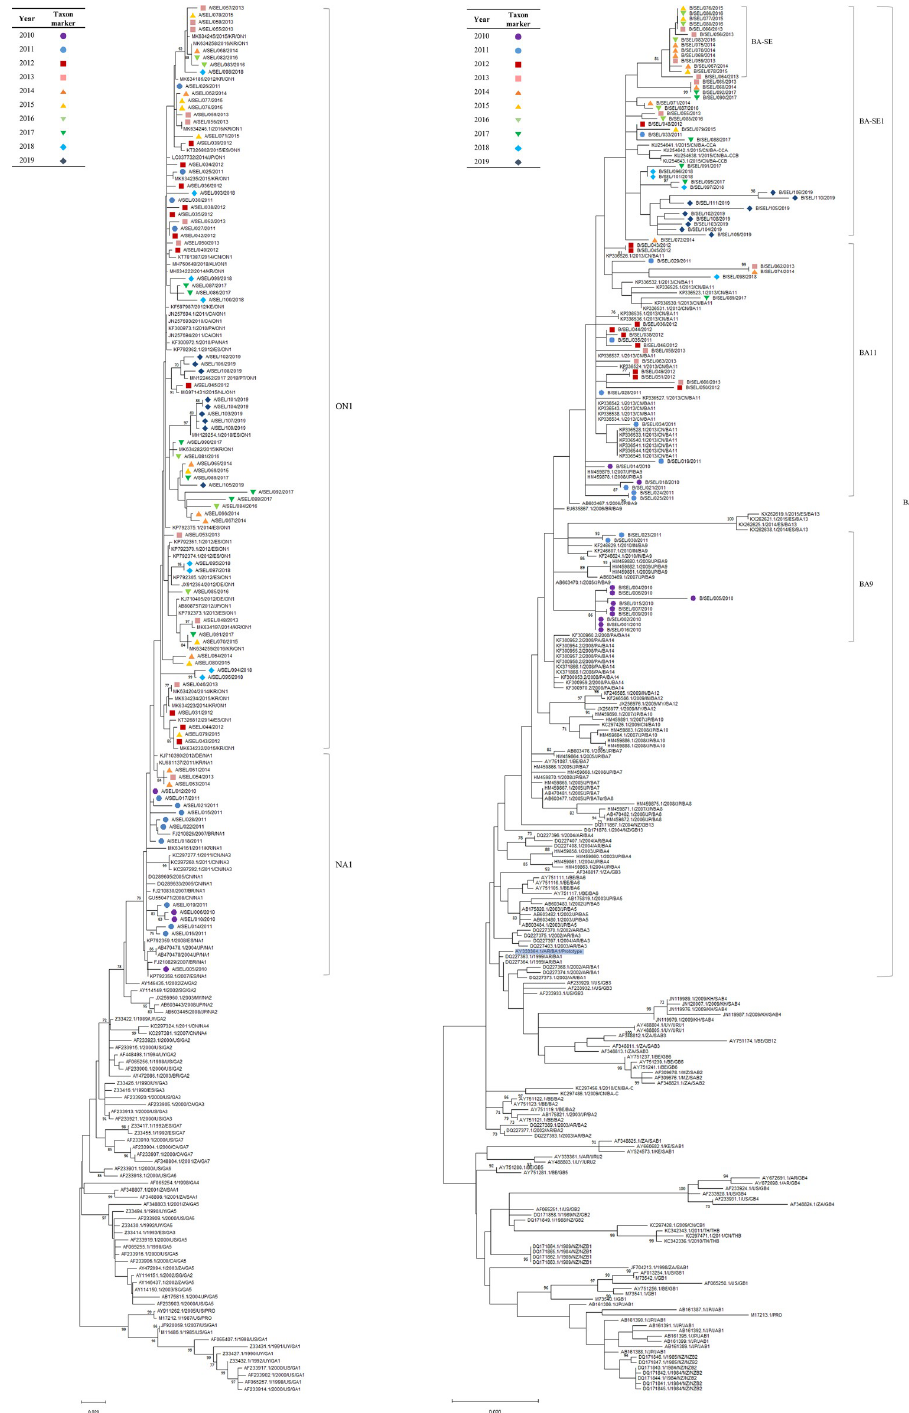
Fig 3. Maximum likelihood (ML) phylogenetic tree of Seoul RSV-A and RSV-B strains. ML phylogenetic trees based on the analysis of partial G gene sequence of RSV-positive samples from 2010–2019 in Seoul, (A) RSV-A and (B) RSV-B. The ML trees were created using the most suitable nucleotide substitution model (TN93 + G) with 1,000 bootstrap replicates by Mega X. Only bootstrap values � 70% are shown for each tree. Strains are labeled with taxon markers of different colors and shapes depending on the collected year, as described in the table on the left-upper side of each ML tree. Reference sequences are expressed in the following format; GenBank accession number/year/country/ genotype. The prototype reference sequence for BA genotype (AY33364.1) was shaded in blue (B).